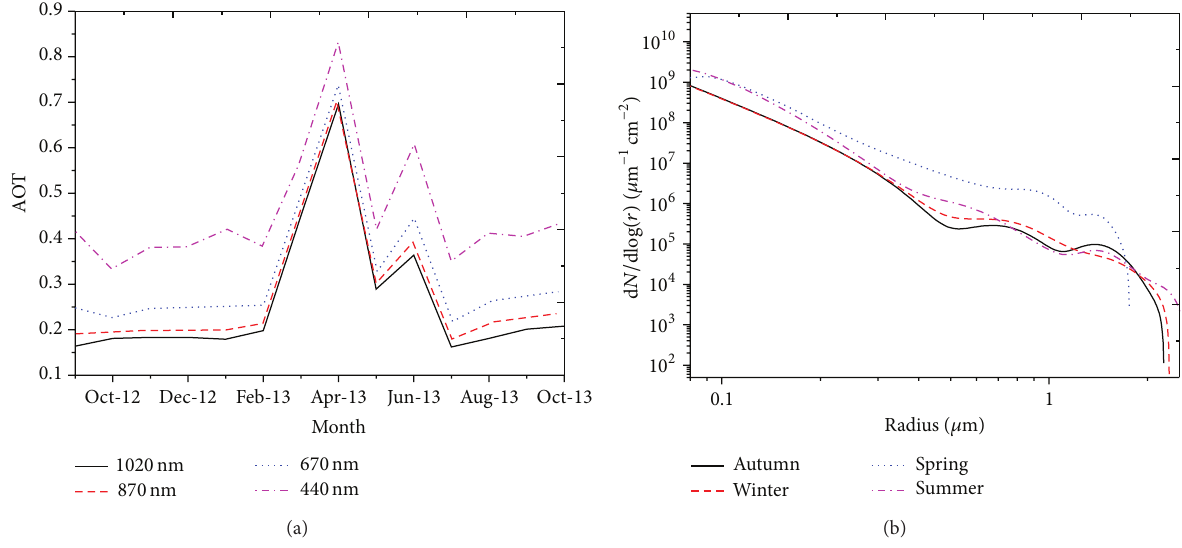
Figure 5: The monthly averaged AOD value and seasonal averaged size distribution of every month.